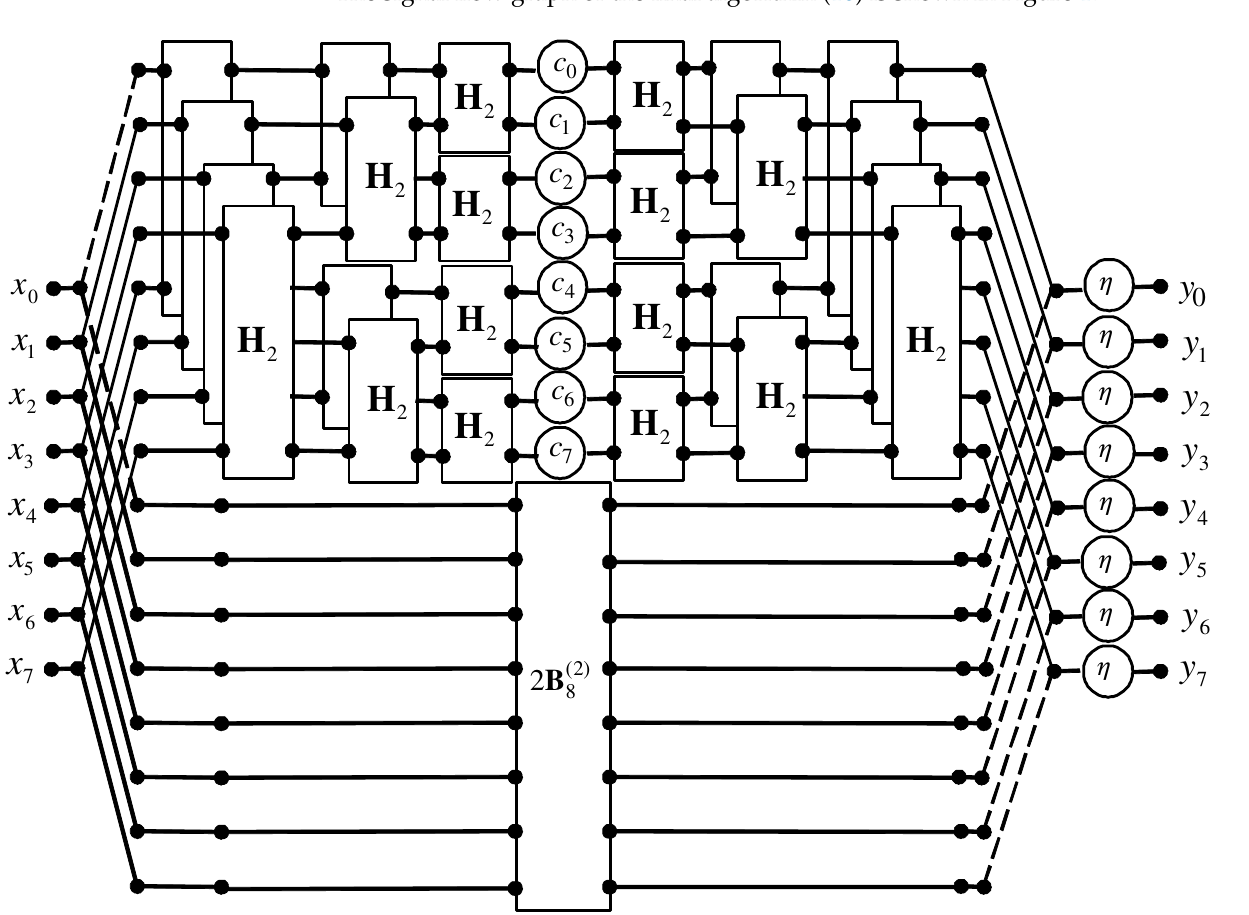
Figure 1. The signal flow graph of the proposed